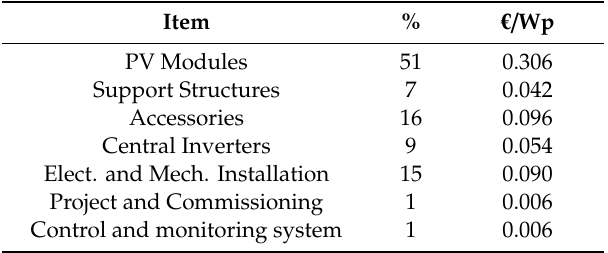
Table A1. Fixed tilt components’ cost (central inverter configuration and portrait disposition).